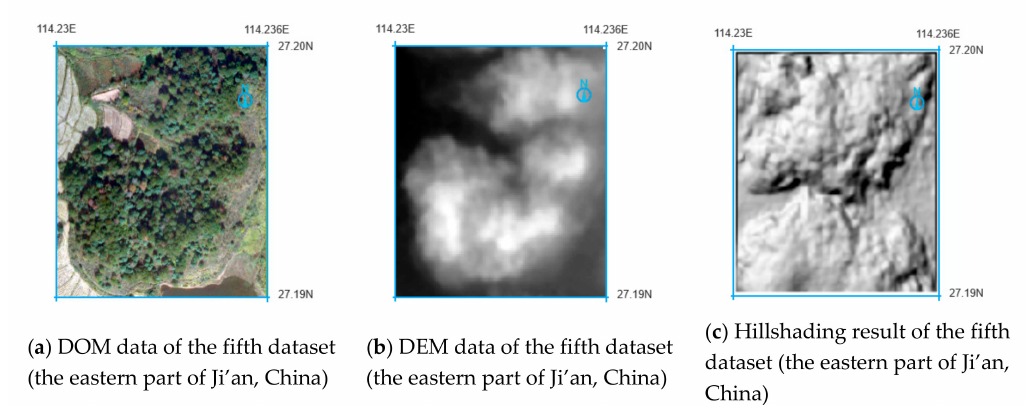
Figure 24. The experimental fifth dataset: ( a ) DOM data of the fifth dataset (the eastern part of Ji’an, China); ( b ) DEM data of the fifth dataset (the eastern part of Ji’an, China); ( c ) hillshading result of the fifth dataset (the eastern part of Ji’an,